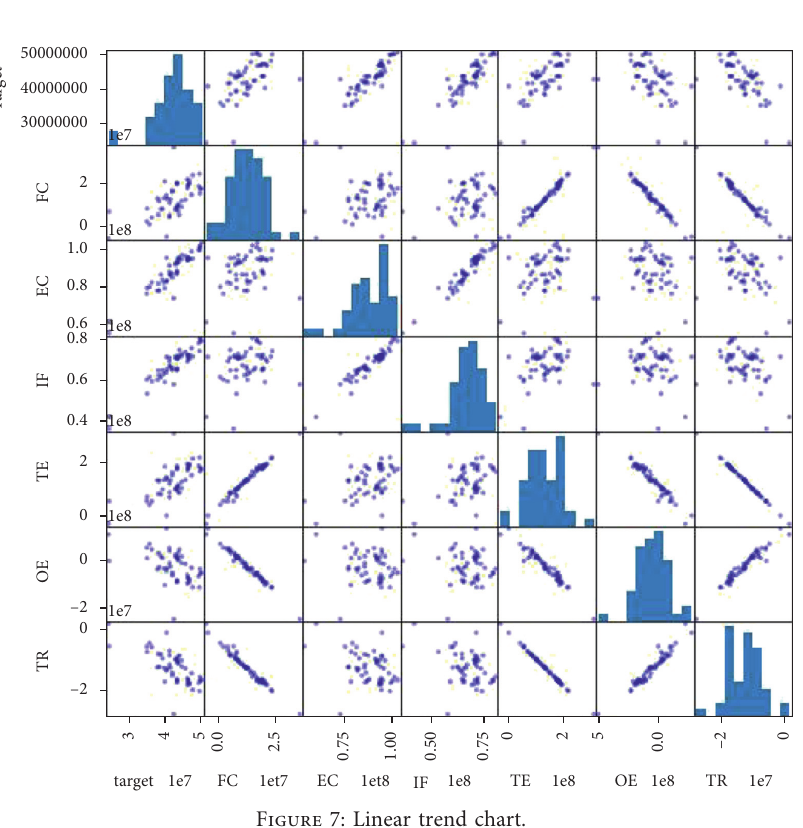
Figure 7: Linear trend chart.